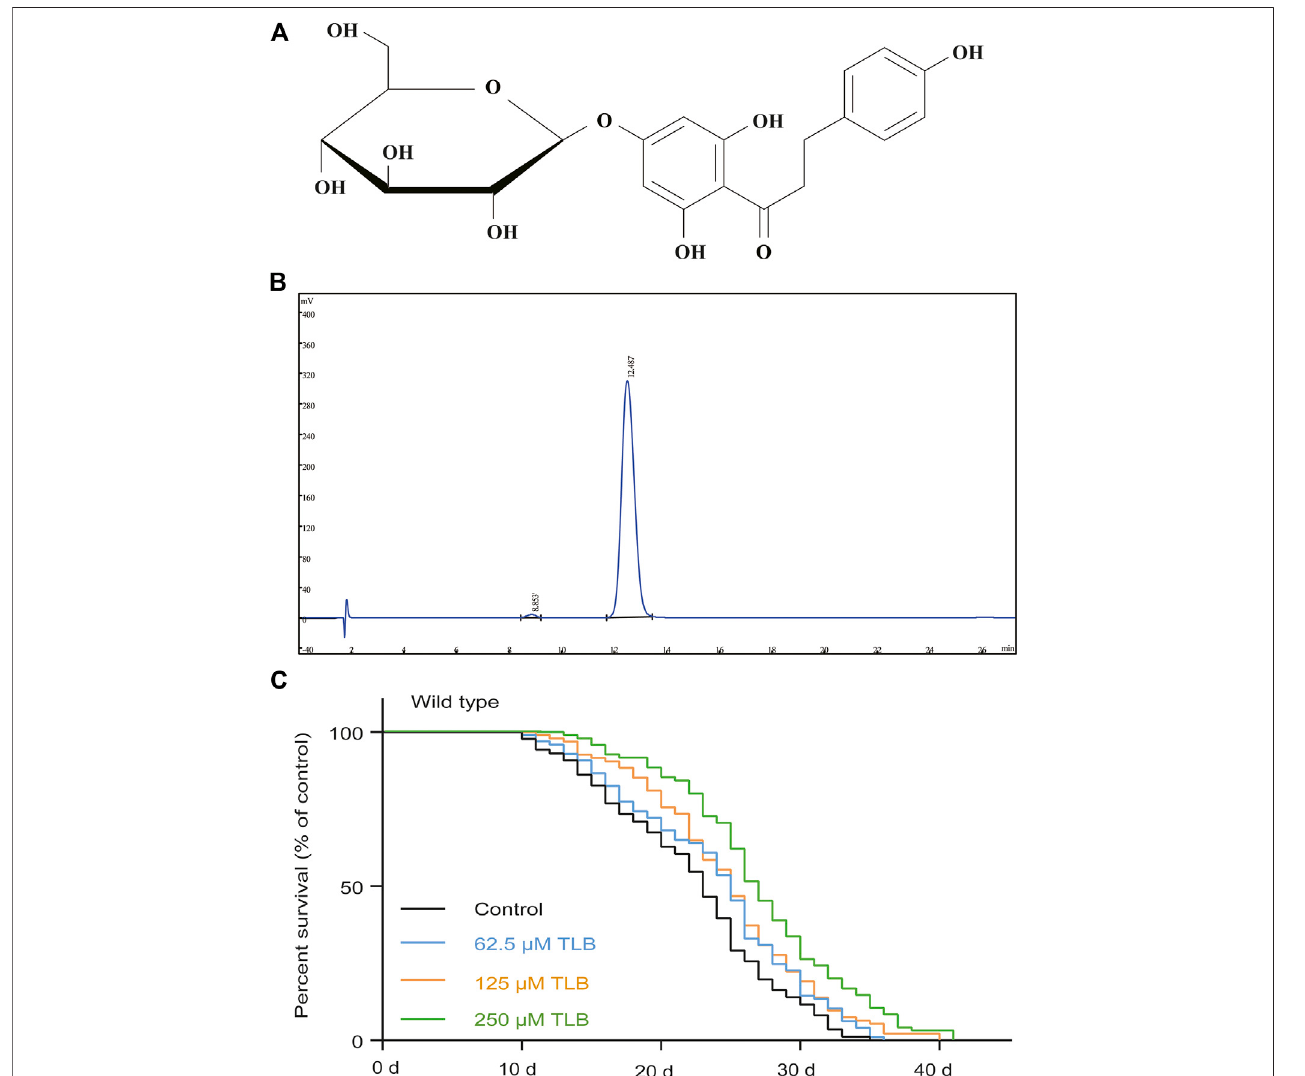
FIGURE 1 | TLB extended lifespan under normal cultivate condition at 20 ° C in wild type C. elegans . (A) The structure of TLB. (B) The high-performance liquid chromatography ofTLB.Wildtype C.elegans weretreatedwithorwithout62.5,125,and250 μ MTLB. (C) TheKaplan-Meier survivalcurvesofwildtype C.elegans ( n (cid:2) 86 – 97). Data were presented as mean ±